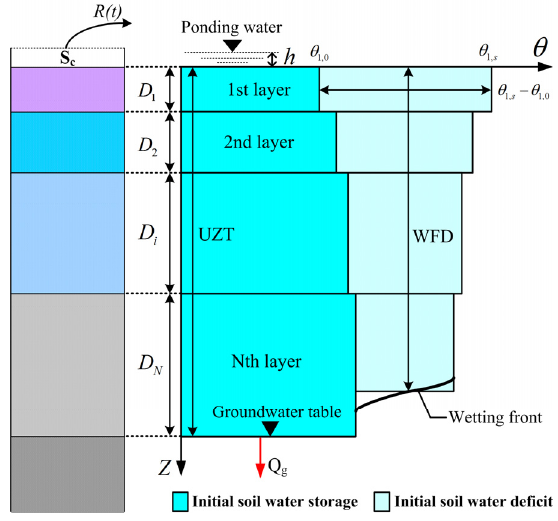
Figure 3. Schematic representation of the Green–Ampt model for layered soils under nonsteady rainfall infiltration.